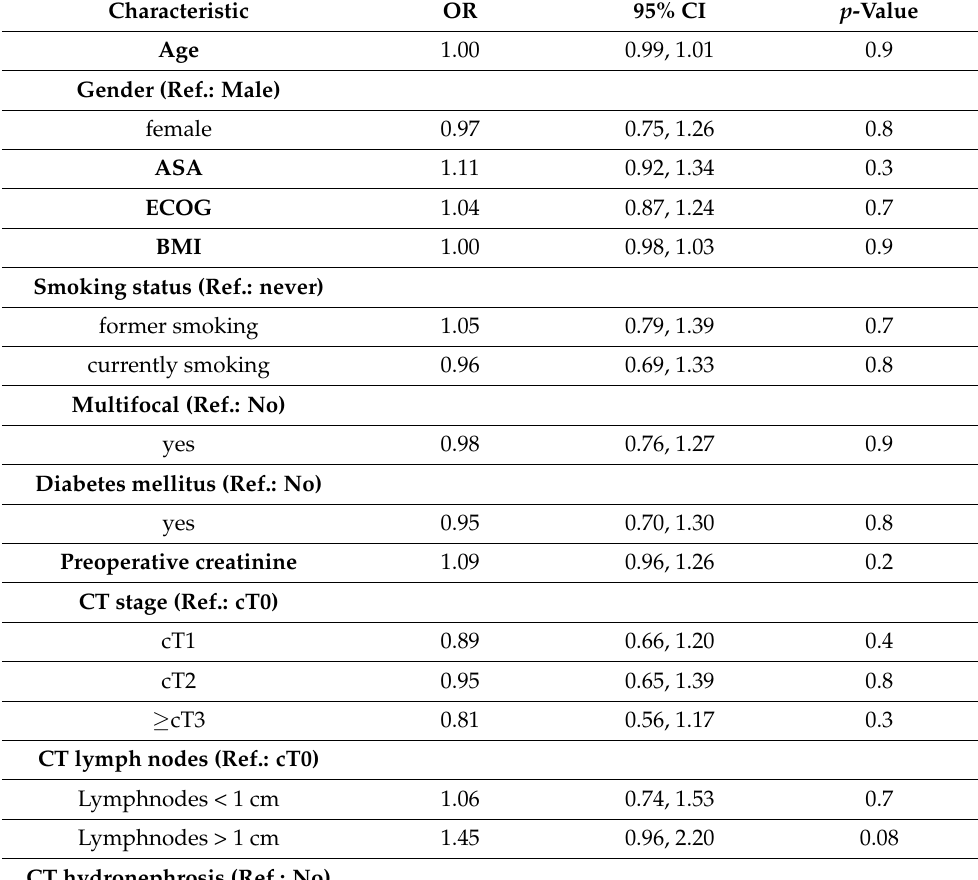
Table 5. Logistic regression analysis assessing predictors for a failure to achieve a pentafecta in patients treated with RNU for high-risk UTUC. ASA = American Society of Anesthesiologists Score; ECOG = Eastern Cooperative Oncology Group Status; BMI = Body mass index; LND = lymph node